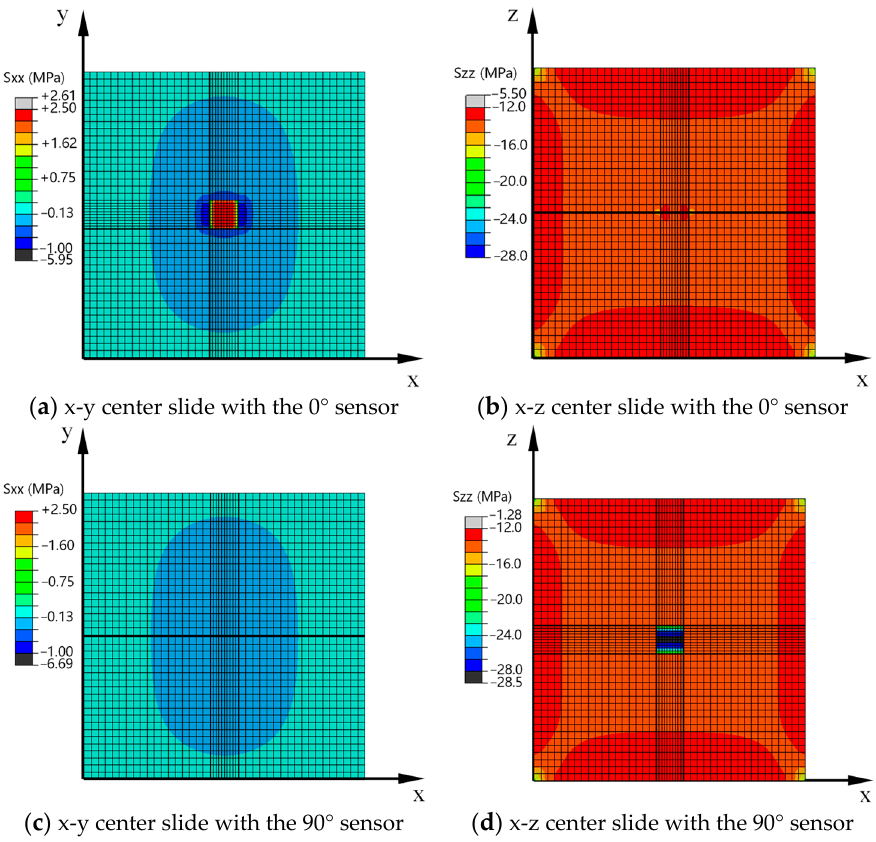
Figure 9. Stress distributions of the center slides involving the 0° and 90° PZT sensors embedded in concrete cubes under the compressive displacement of 0.04 mm.